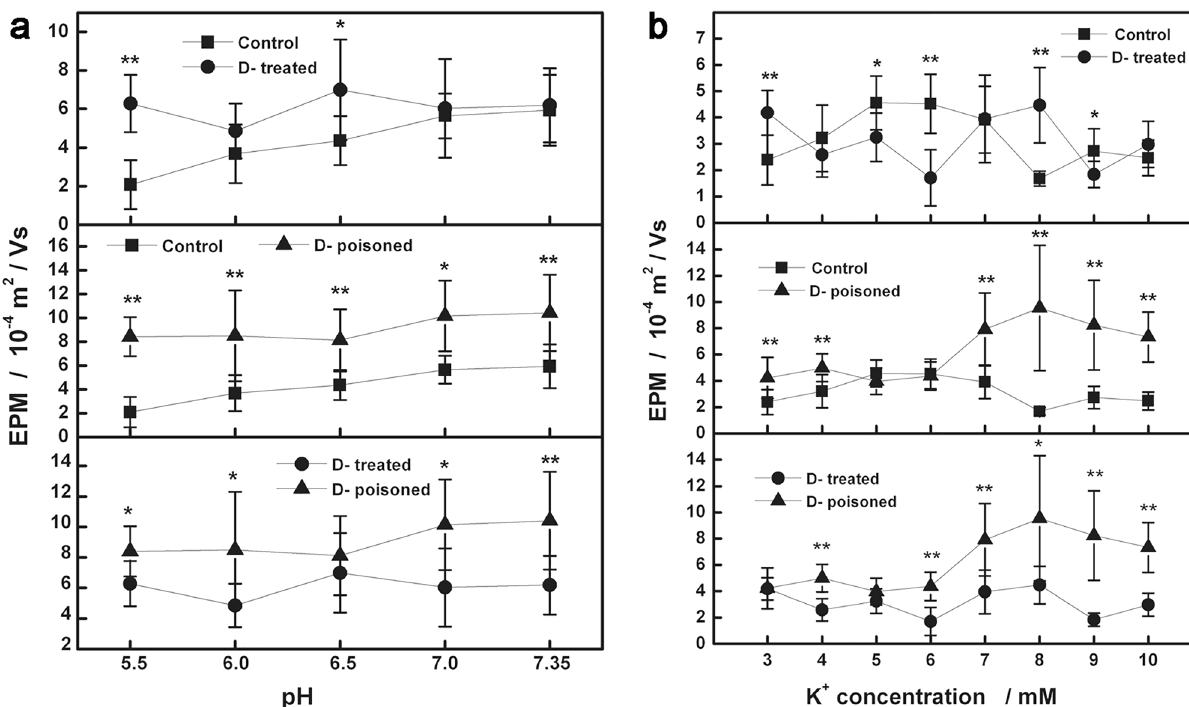
Figure 1. In different suspensions impact of digoxin on EMP of cardiomyocyte. ( a ) Changes of three groups EPM measured in the suspensions of 145 mM NaCl, 2 mM CaCl 2 , 4 mM KCl and pH 5.5–7.35. ( b ) Three groups EPM measured in the suspensions of 145 mM NaCl, 2 mM CaCl 2 , 3–10 mM KCl and pH